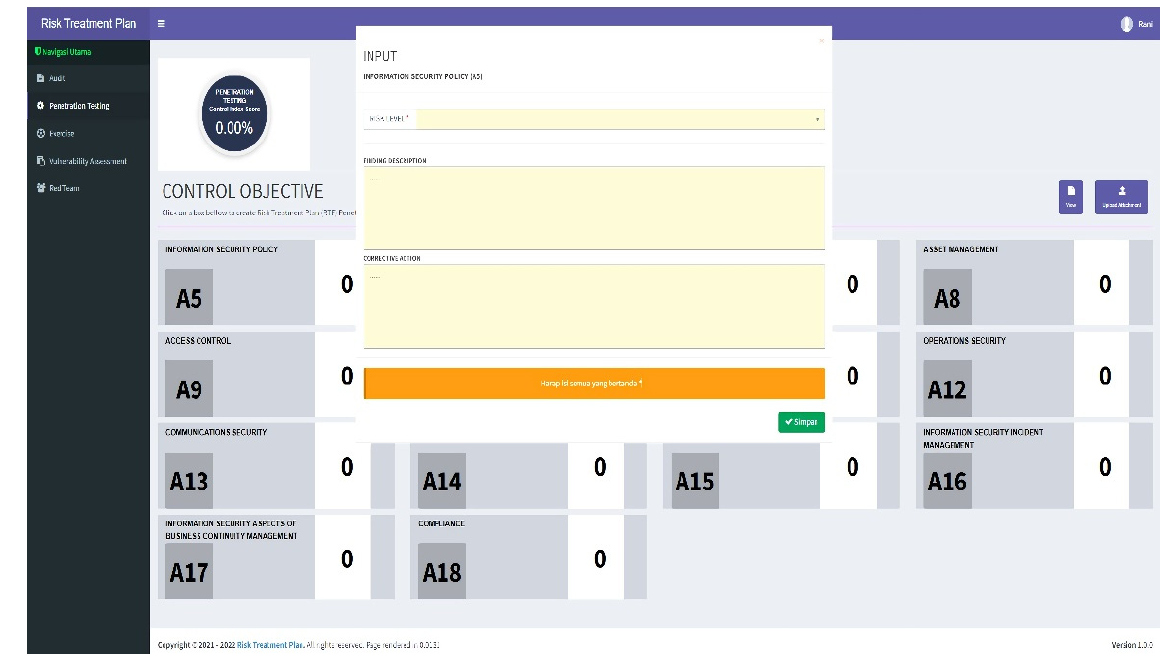
Figure 11. Application Features for Monitoring and Evaluating Risk Treatment Plan Controls.